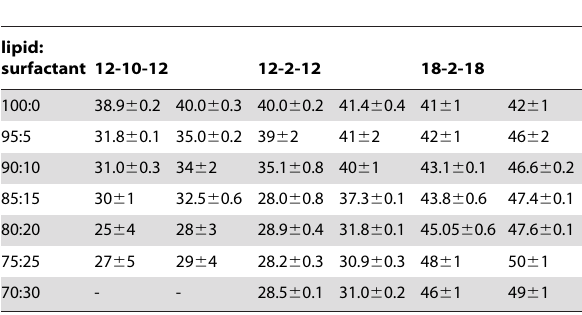
Values of T onset (left columns) and T max (right columns), indicated by mean 6 SD (minimum of three repetitions), for the detected phase transition, extracted from the DSC thermograms of DPPC/CHO systems for the indicated molar percentages. A scanning rate of 10 u C/min was